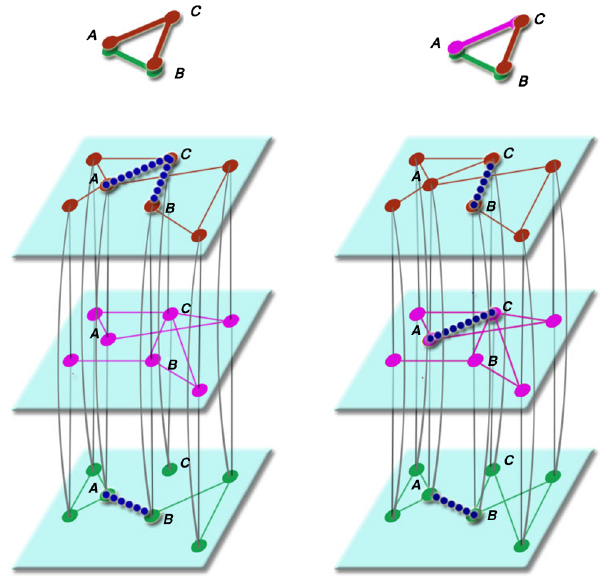
FIG. 4. Schematic of closing triangles in multiplex networks. Triangles can be closed using intralayer connections from differ- ent layers. In the figure, we show two different situations that can arise. For example, the left panel might represent a multilayer social network in which nodes A and B are friends of node C but are not friends with each other (first layer), but nodes A and B still have a social tie because they work in the same company even though node C does not work there (third layer). In the right panel, one might imagine that each layer corresponds to a different online social network: Perhaps node B tweets about an item; node C sees node B ’s post on Twitter (first layer) and then posts the same item on Facebook (second layer); node A then sees this post and blogs about it (third layer), and node B reads this blog